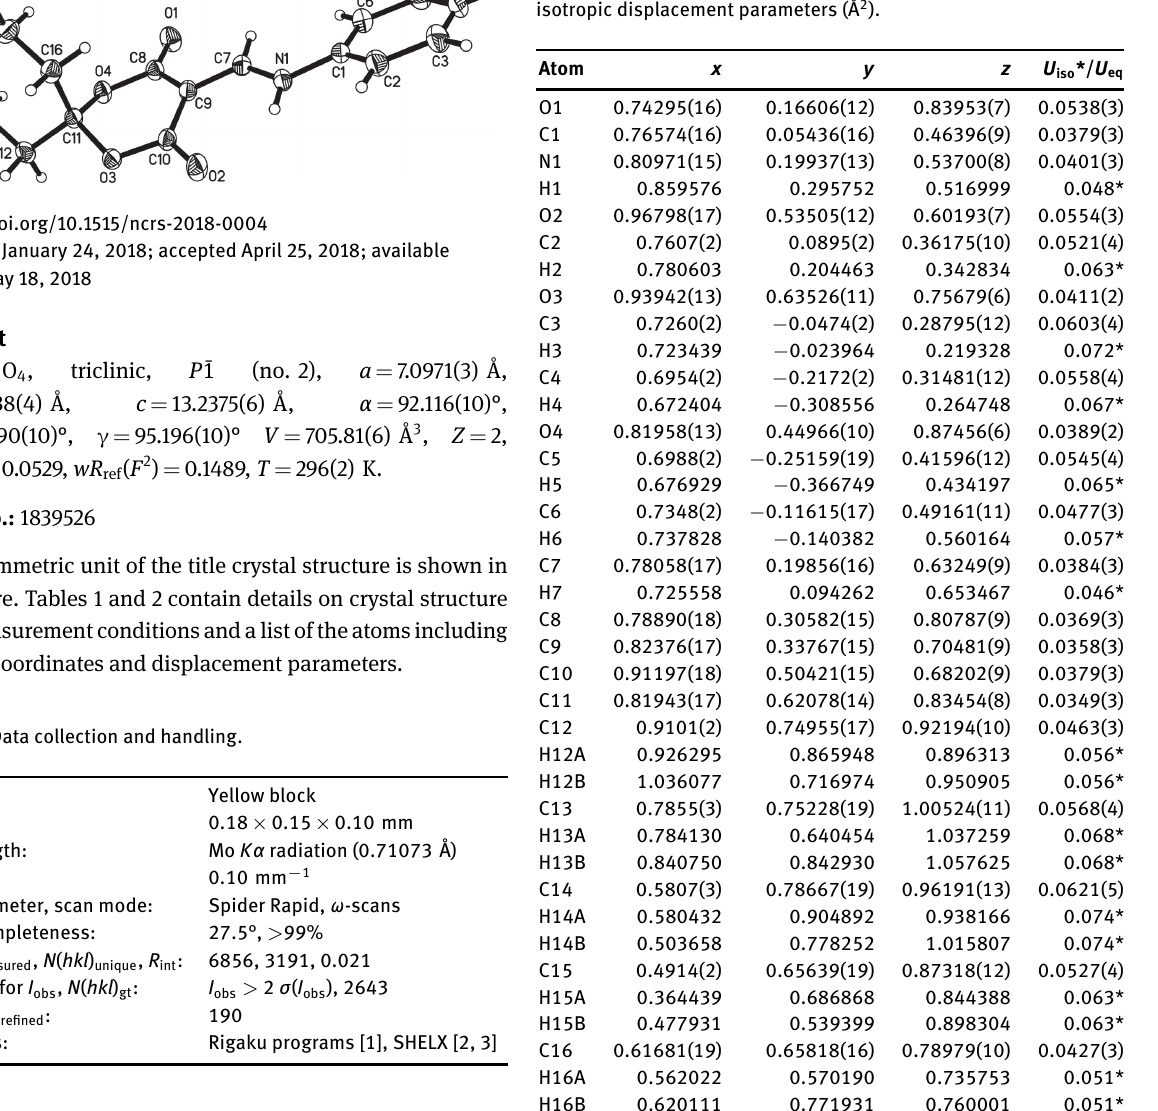
Table 2: Fractional atomic coordinates and isotropic or equivalent isotropic displacement parameters (Å 2